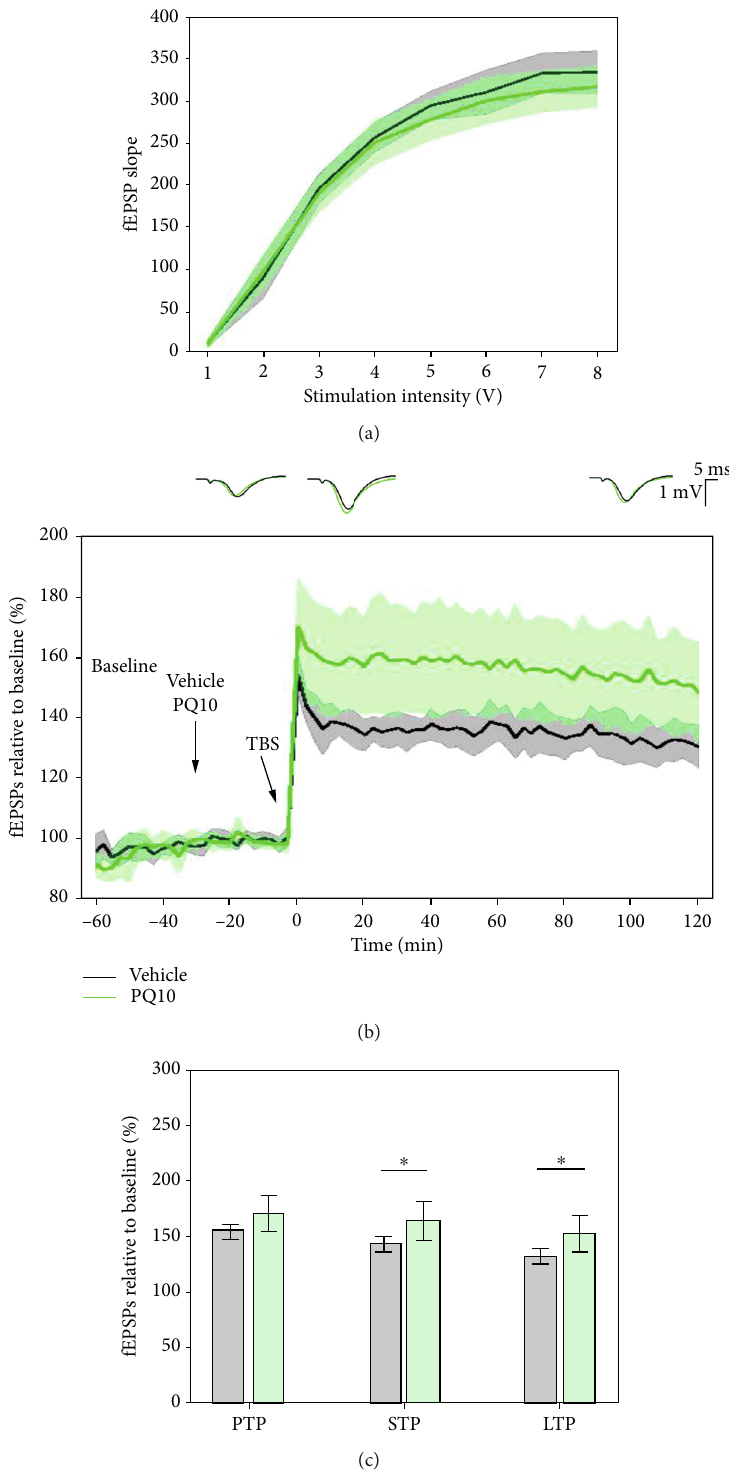
Figure 13: PQ10 enhanced the LTP response to the 5 × TBS protocol. (a) Input/output curves showing no signi fi cant di ff erences among groups. (b) PQ10-treated (green, n = 8 ) subjects had increased fEPSPs during the 2-hour posttetanisation recording as compared to control (black, n = 10 ). Values represent means ± 95 % confidence intervals . Outsets above LTP curves represent average waveform fi eld potentials during 30min baseline prior to tetanisation and 0-30min and 90-120 min posttetanisation. Horizontal bar: 1 mV; vertical bar: 5ms. (c) PTP, STP, and LTP responses are presented as means ± 95 % confidence interval ; ∗ p value < 0 : 05